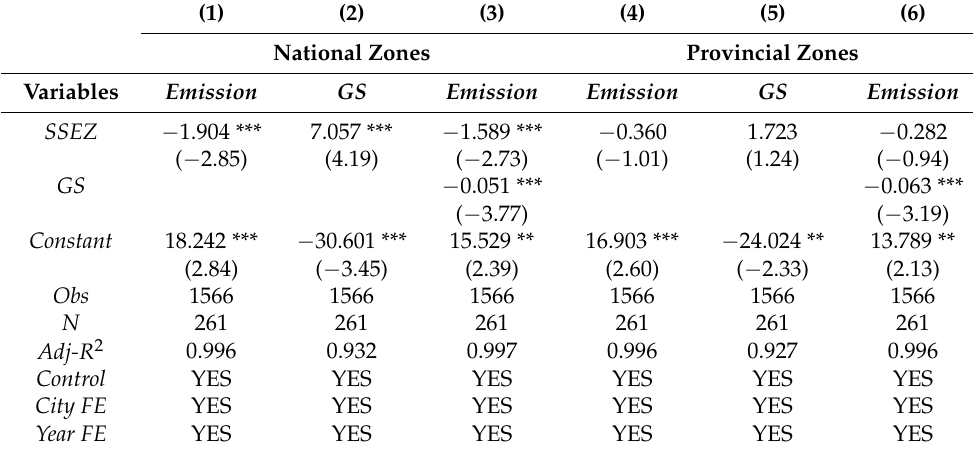
Table 9. Heterogeneity analysis by administration